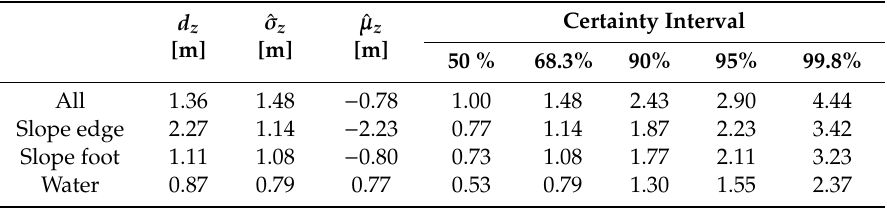
Table 3. Absolute vertical error of DMR 3.5 calculated by Equations (2)–(4), Section